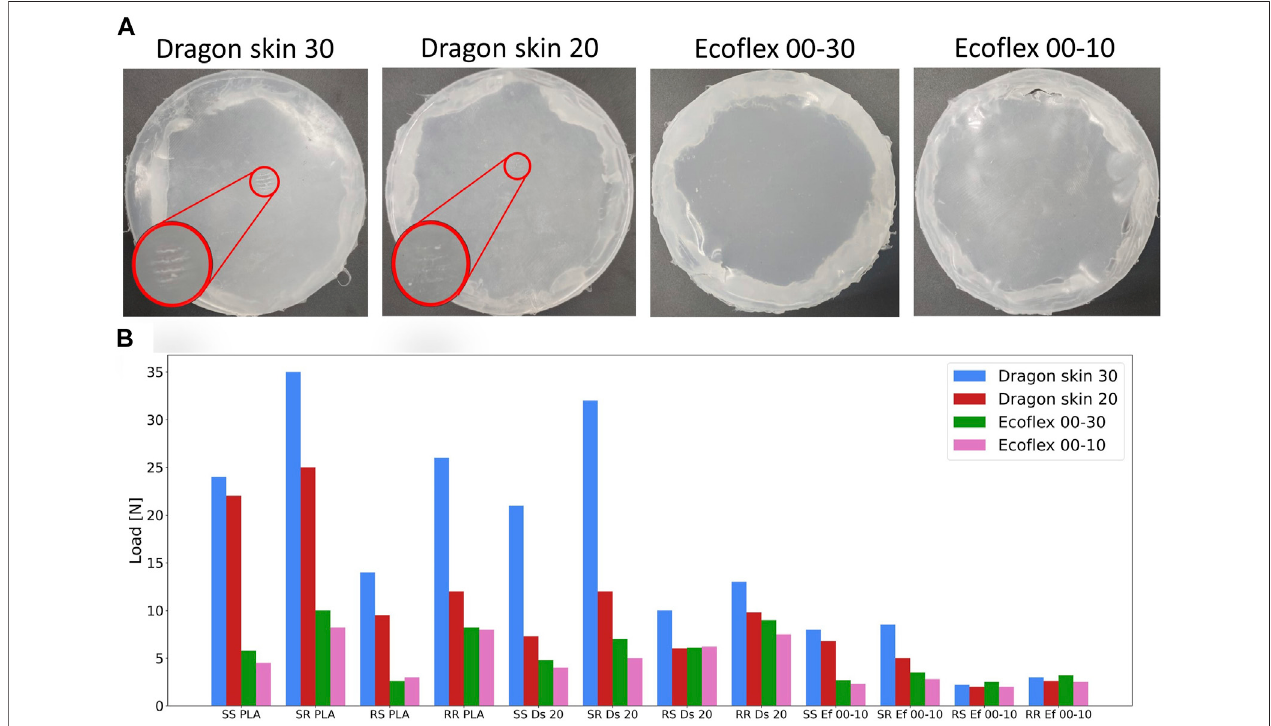
FIGURE12 | Tactile fi ltersafter theend ofthe experimental trials (A) . Anydamage on theouter diameter isdue tothe removal ofthe fi lterfrom the end-effector and not from the contact with the test set. Measured load applied on each fi lter while performing the experiment (B) . Objects ’ names are as follows: “ SS ” is Square Smooth, “ SR ” is Square Rough, “ RS ” is Round Smooth, “ RR ” is Round Rough, “ Ds ” is Dragon Skin, and “ Ef ” is Eco fl ex.